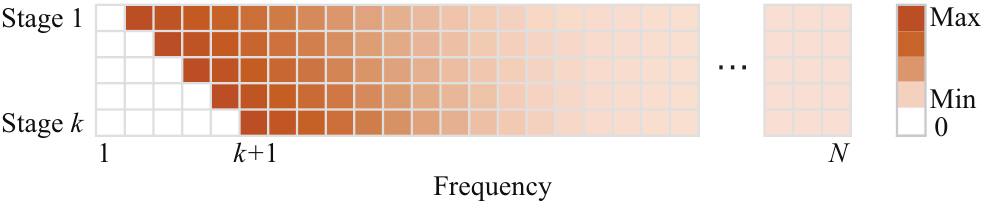
Figure 1. Illustration of the attentions on coefficients of different frequencies in different stages. Each line illustrates the attention distribution of one stage. Attention equals to 0 indicates that the corresponding frequency coefficient does not need to be